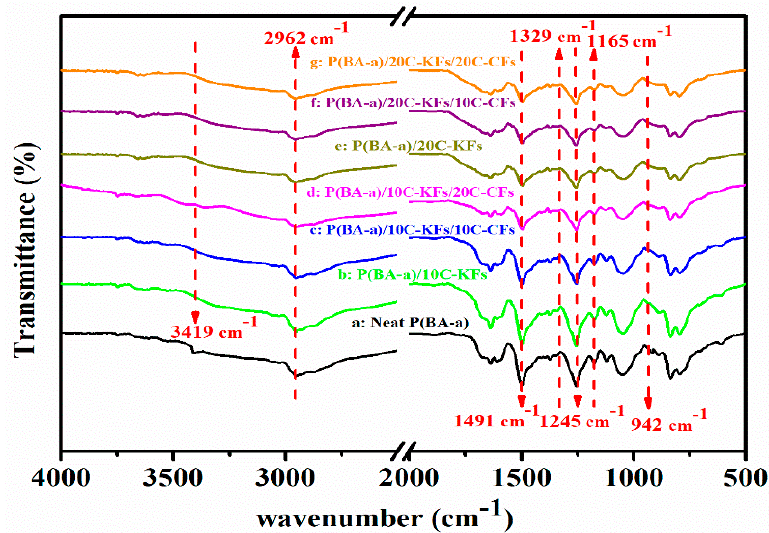
Figure 3. FTIR of the hybrid composites with different hybrid fiber contents.